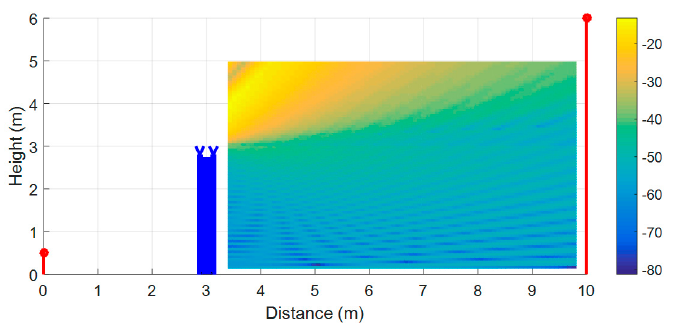
Figure 21. Attenuation map at 1500 Hz in the ‘car’ location. Barrier with the ‘Y–Y’ cap and 3 m height.